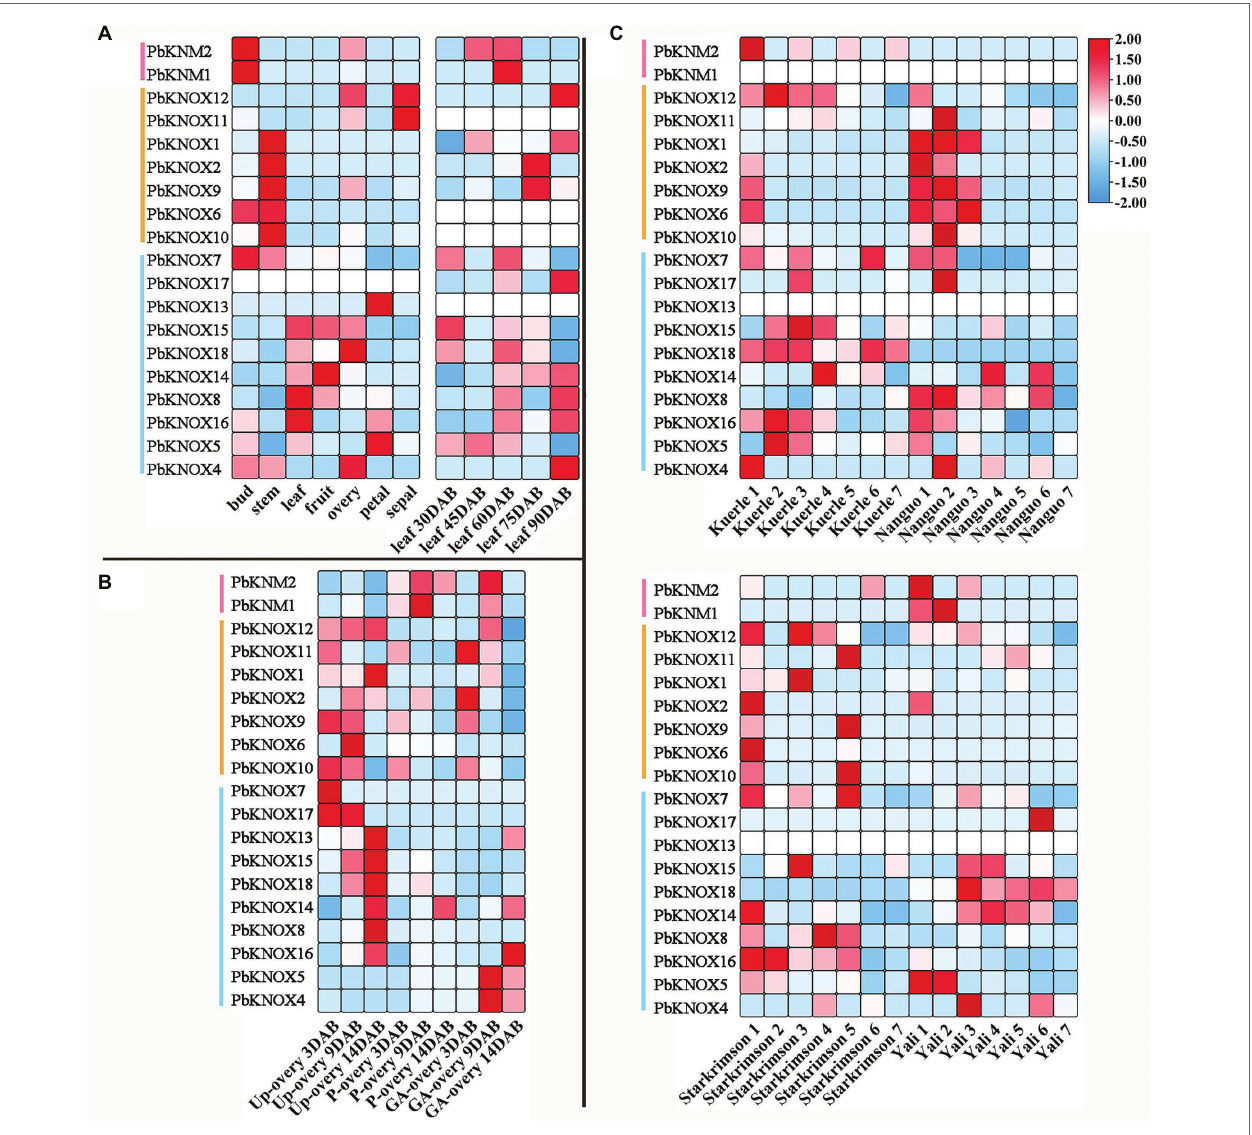
FIGURE 4 | Expression profiles of PbKNOX s in pear. (A,B) Expression profile of PbKNOX s in leaf (A) and ovary at different development stages (B) of Pyrus bretschneideri . (C) Expression profile of PbKNOX s at different fruit development stages in various Pyrus bretschneideri varieties. P-ovary, pollinated ovary; Up-ovary, unpollinated